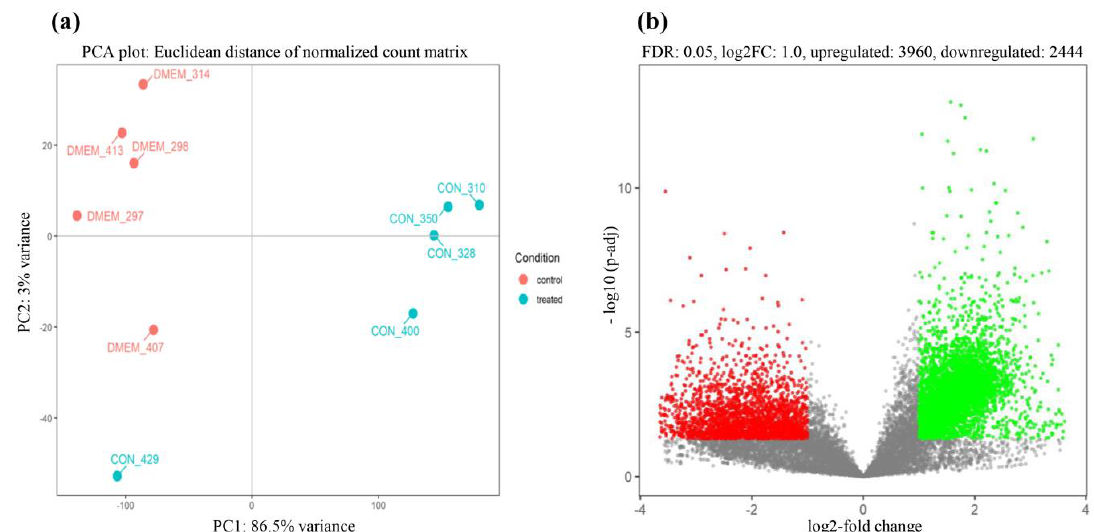
Figure 2. Two-dimensional principal component analysis (PCA) plot and volcano plot. ( a ) Principal component analysis (PCA) score plot. The control animals are indicated by red dots labeled “DMEM_ animal number,” while the CON90-infected animals are indicated by cyan dots labeled “CON_animal number”; ( b ) the volcano plot of di ff erentially expressed genes between CON90-infected and control pigs. Red dots denote significantly down-regulated genes ( p < 0.05, log 2 fold change ≤− 1), green dots indicated significantly up-regulated genes ( p < 0.05, log 2 fold change ≥ 1), and grey dots represent genes that were not di ff erentially expressed.